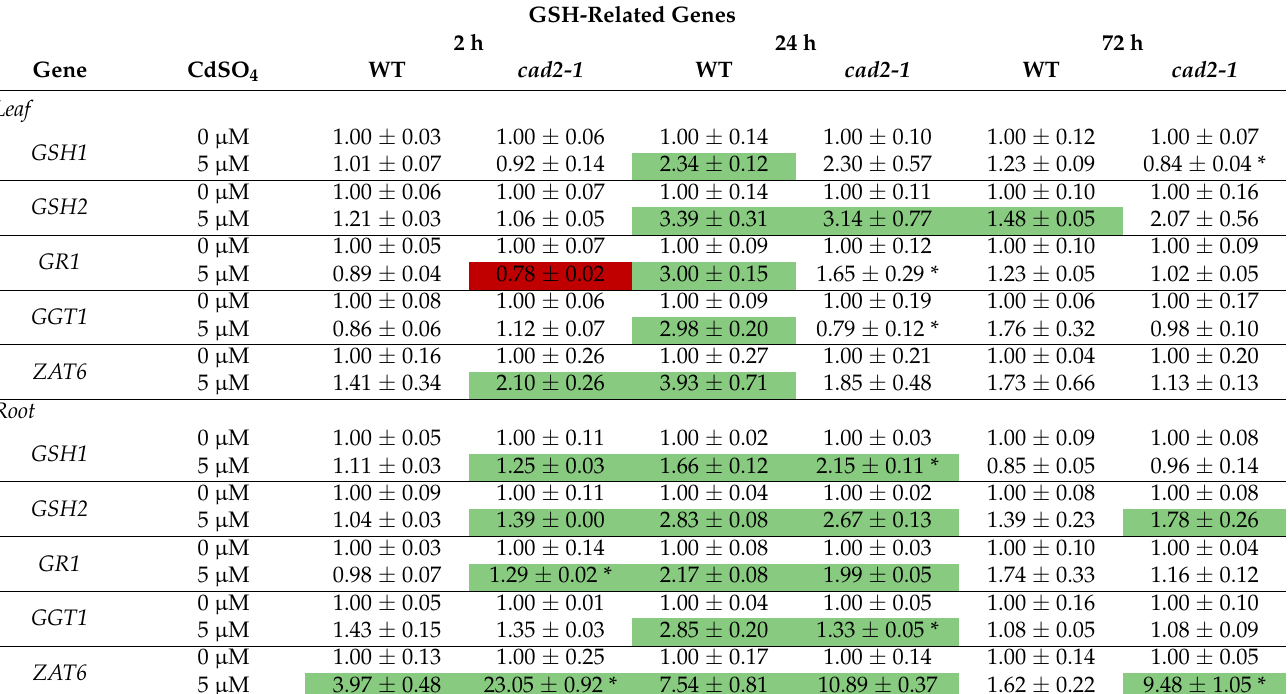
Table 2. Relative gene expression levels of glutathione (GSH)-related genes in leaves and roots of 3-week-old wild-type (WT) and cad2-1 mutant Arabidopsis thaliana plants grown under control conditions (0 µ M CdSO 4 ) or exposed to 5 µ M CdSO 4 during 2 h, 24 h, and 72 h. Data are